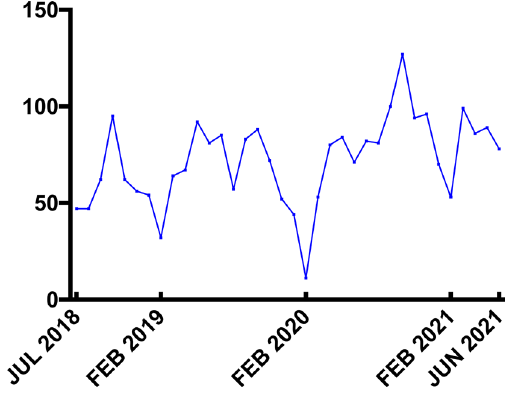
Fig. 1 Monthly distribution of trauma center